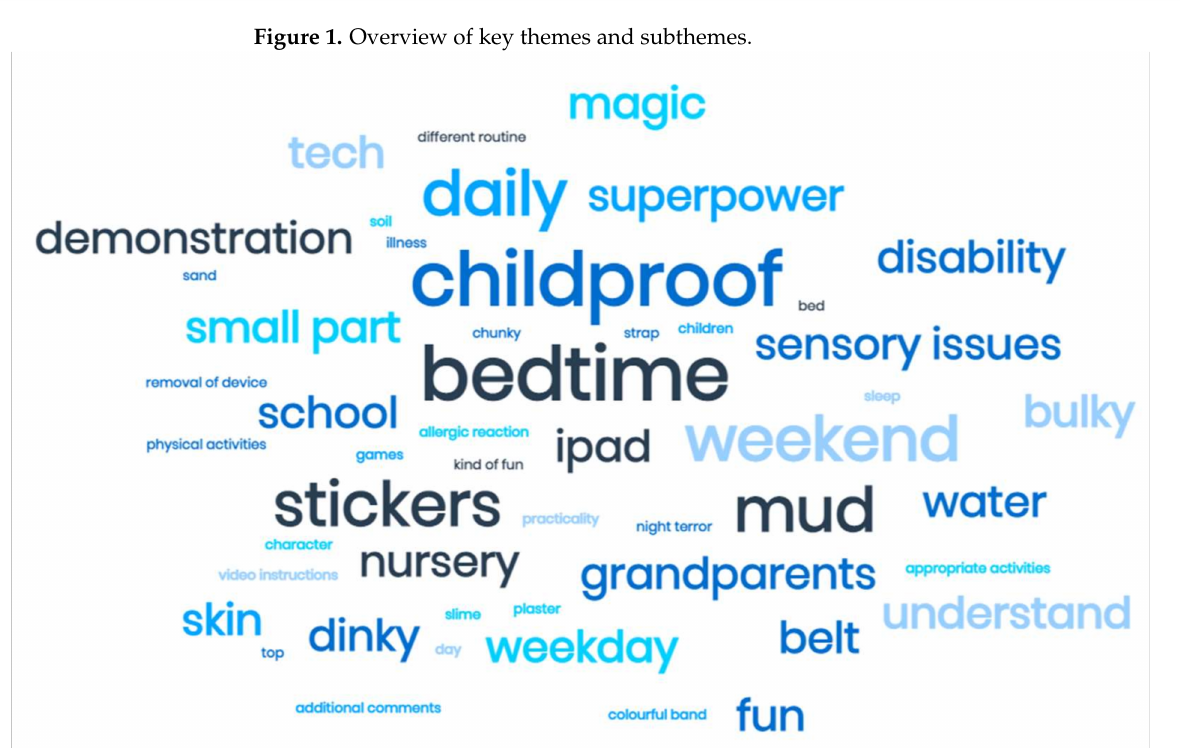
Figure 2. Word cloud representation of the